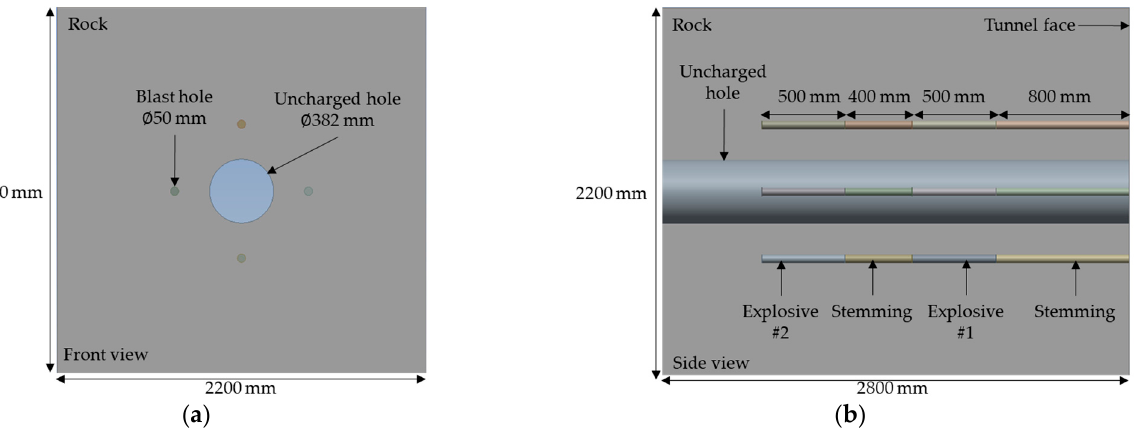
Figure 10. Geometry of the numerical simulation model for modified LLB method utilizing the deck charge technique: ( a ) front view and ( b ) side view.